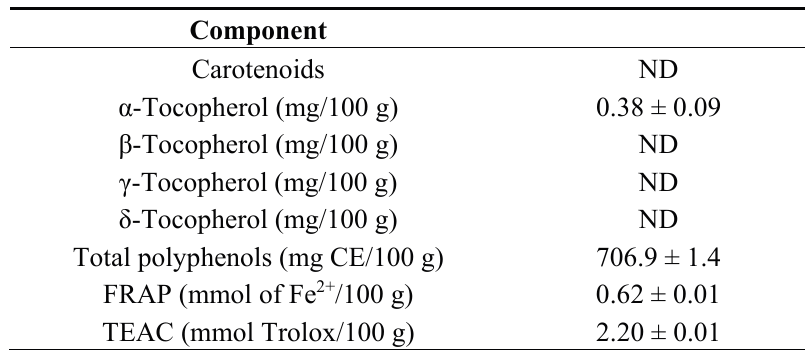
Table 4. The content of carotenoids, tocopherols, total polyphenols and total antioxidant capacity of Bambara groundnut a